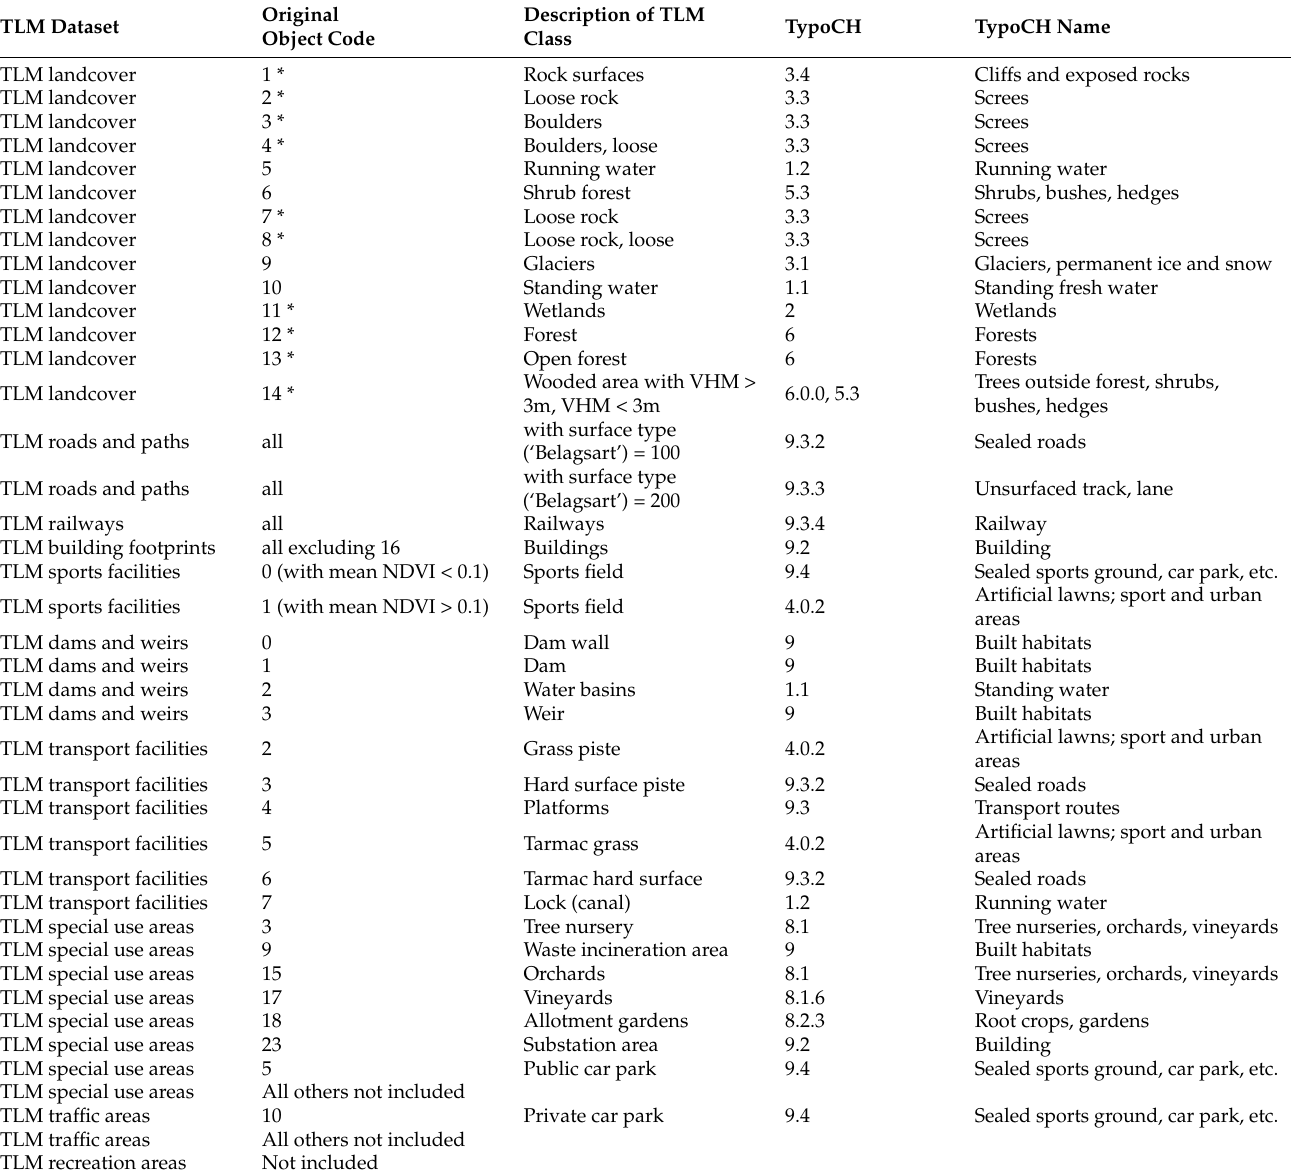
Table 2. TLM data included in the habitat map with source sub-dataset and translation to TypoCH. The dataset TLM Landcover (original name: BODENBEDECKUNG) is used in an initial coarse eCognition classification. Asterisked * classes are then further classified using the methodological approaches 2, 3 or 4 detailed in Table 1. All other TLM datasets indicated in the table are incorporated as an overlay, after eCognition processing, using the software ArcGIS Pro v2.7.1. The field object code (original name: OBJEKTART) shows the TLM object class from the original TLM sub-dataset [26]. NDVI is the normalised difference vegetation index calculated from the 1m aerial